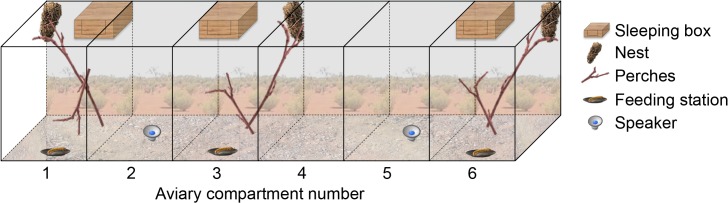
Schematic of aviary setup.The aviary consisted of six compartments: the back comprised metal meshing (1 cm2), allowing the birds an outside view; the two sides were made of aluminium; and the front was specially designed perspex, allowing a one-way view from outside to inside. Occupied compartments contained natural perches, foraging substrate, a feeding station, babbler nest, and sleeping box, while unoccupied compartments contained the playback apparatus. Babbler nests are large (~45 x 30 cm), dome-shaped, with 6 cm diameter entrance hole, and robust. Babblers spent most of their time at mid-height; in all cases, relative to the speaker, birds had to look behind and up to look at the nest. Single birds used compartment 3 (n = 2), pairs of birds used compartments 1 and 3 (n = 1 pair) and trios used compartments 1, 3, and 6 (n = 4 trios) (S2 Text).